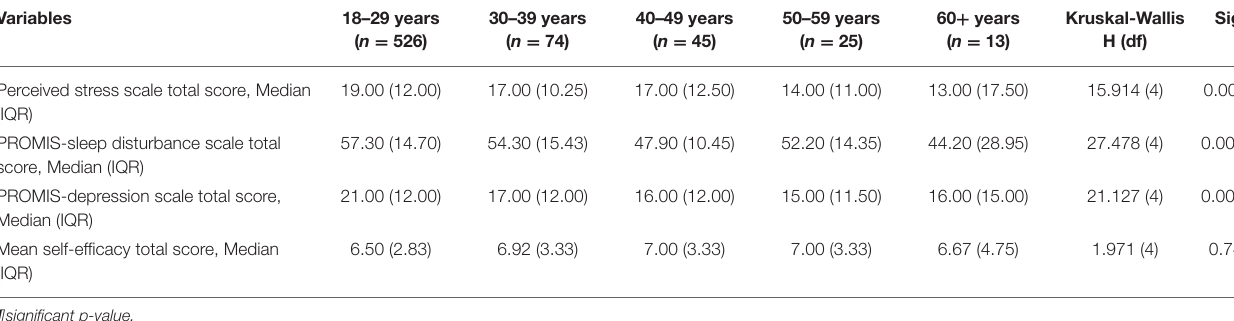
TABLE 3 | Perceived stress, sleep disturbance, depression, and self-efficacy stratified by age ( N = 683).